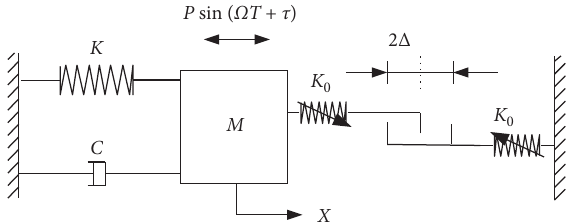
Figure 2: Equivalent dynamic model of the hinge